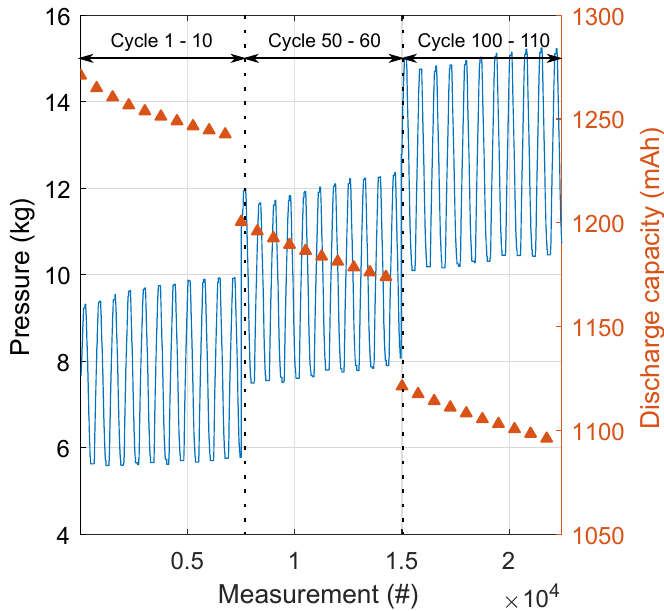
Figure 12. Measured perpendicular pressure evolution due to volumetric constraints of a Si-alloy pouch cell and the discharged capacity during cycles 1–10, 5–60 and